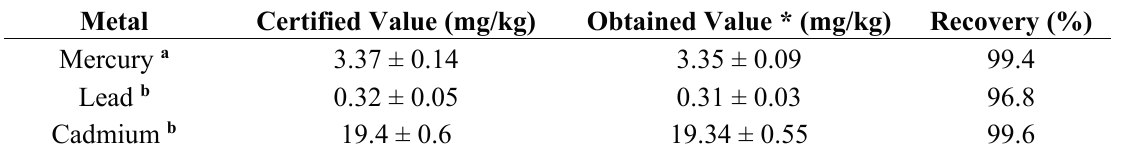
Table 1. Recoveries of certified reference material